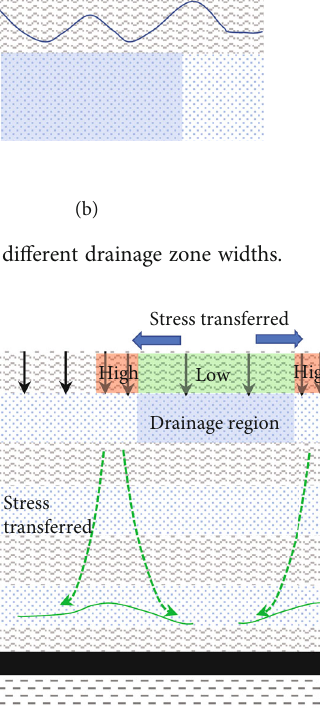
Figure 4: Stress transfer model after